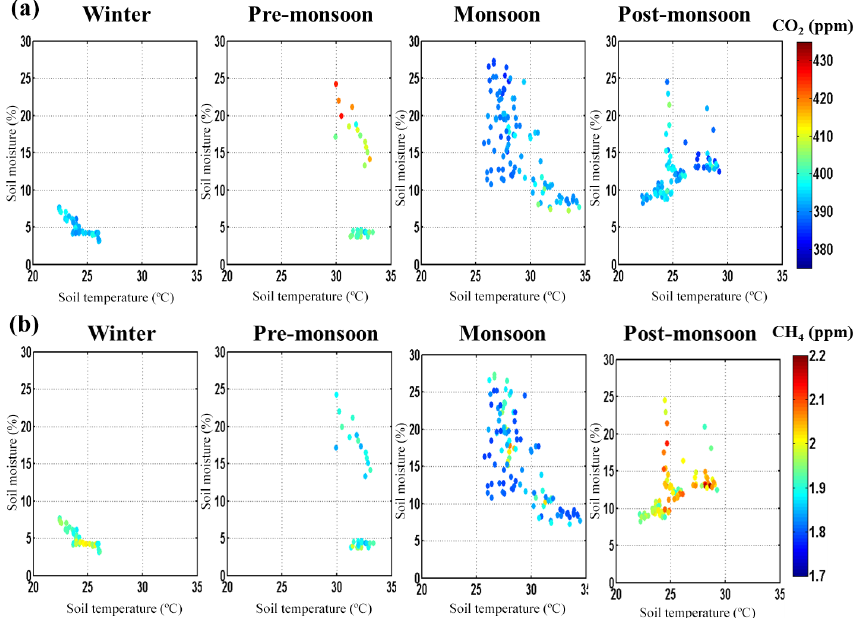
Figure 8. (a–b) Daily means seasonal variation of CO 2 and CH 4 as a function of soil temperature and soil moisture during